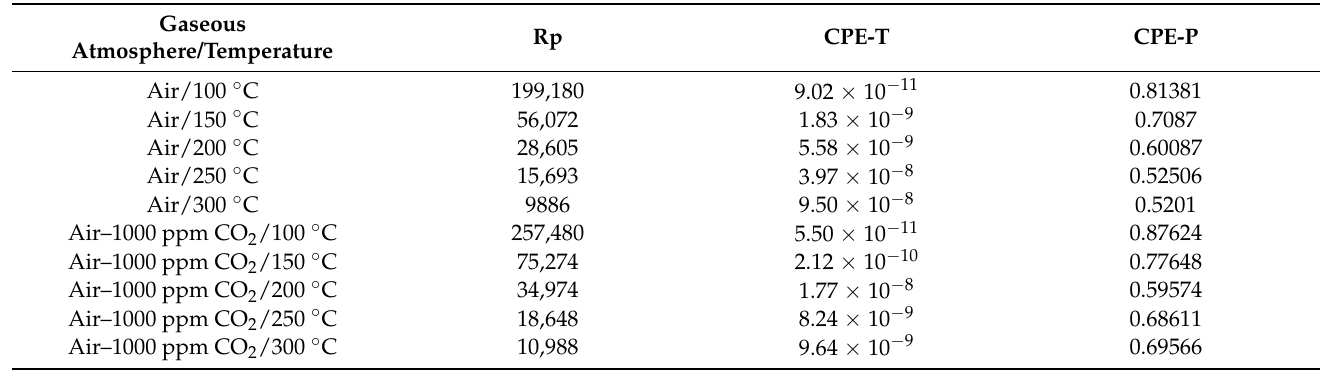
Table 5. The fitted parameters with the equivalent circuit for ITO:Zn/Si film.